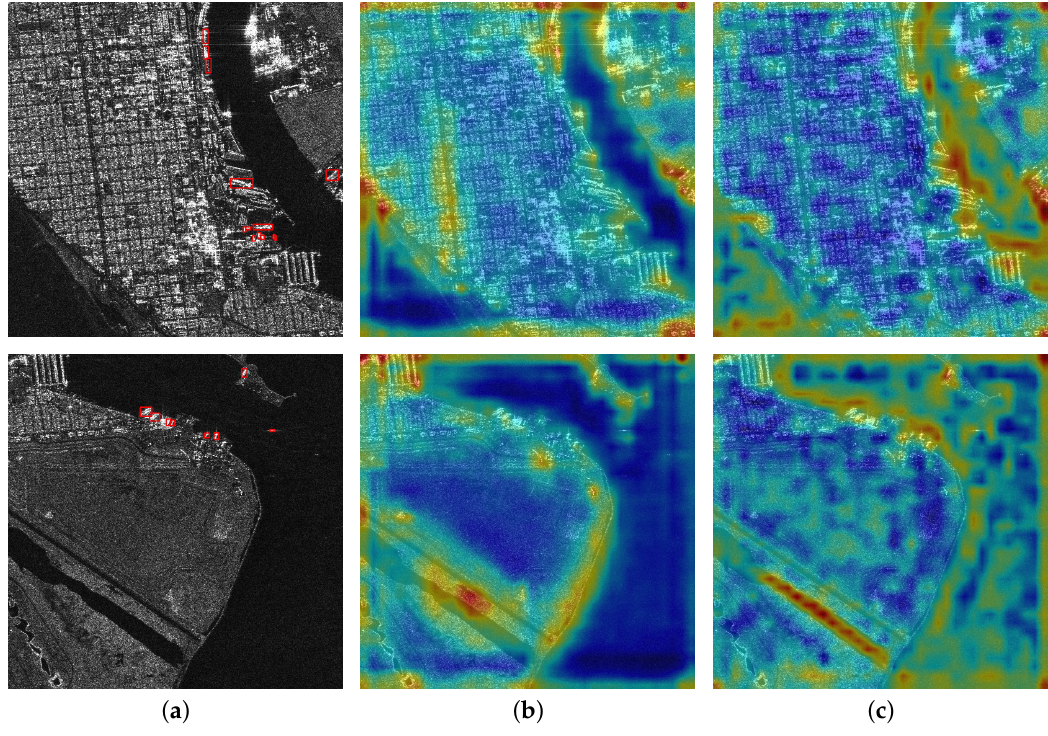
Figure 6. Comparison of features with and without convolution-level alignment. ( a ) SAR images with ground-truths. ( b ) Feature maps w/o convolution-level alignment. ( c ) Feature maps w/ convolution- level